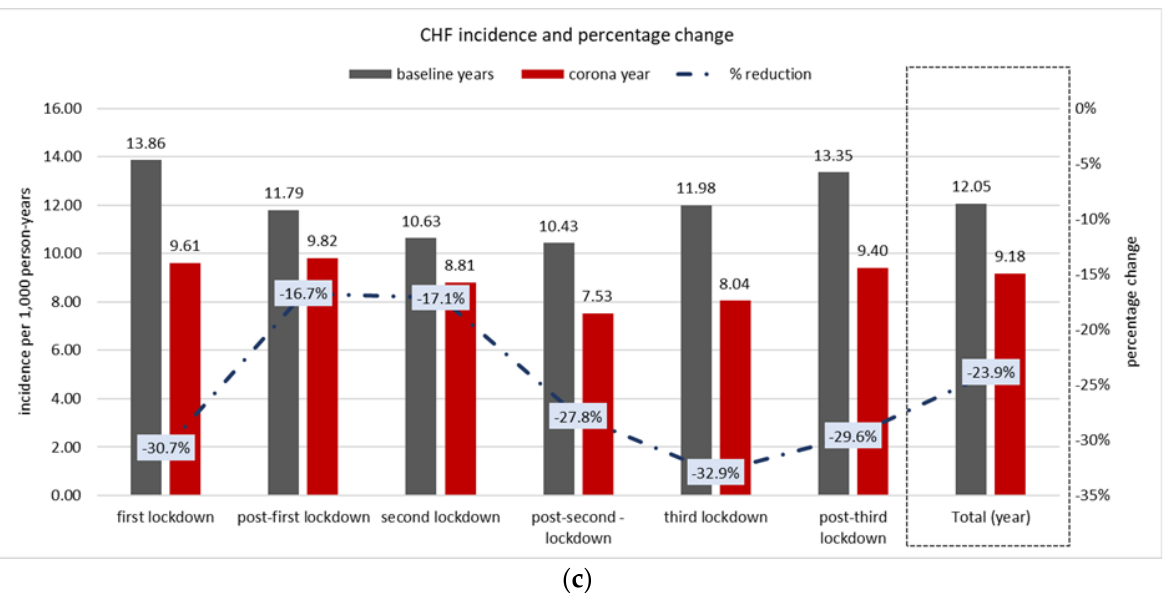
Figure 1. ( a ) STEMI incidence by period during the Corona year and the average of preceding three years, and percentage change (hospitalization cases per 1000 person-years). ( b ) Non-STEMI incidence by period during the Corona year and the average of preceding three years, and percentage change (hospitalization cases per 1000 person-years). ( c ) CHF incidence by period during the Corona year and the average of preceding three years, and percentage change (hospitalization cases per 1000 person-years.).